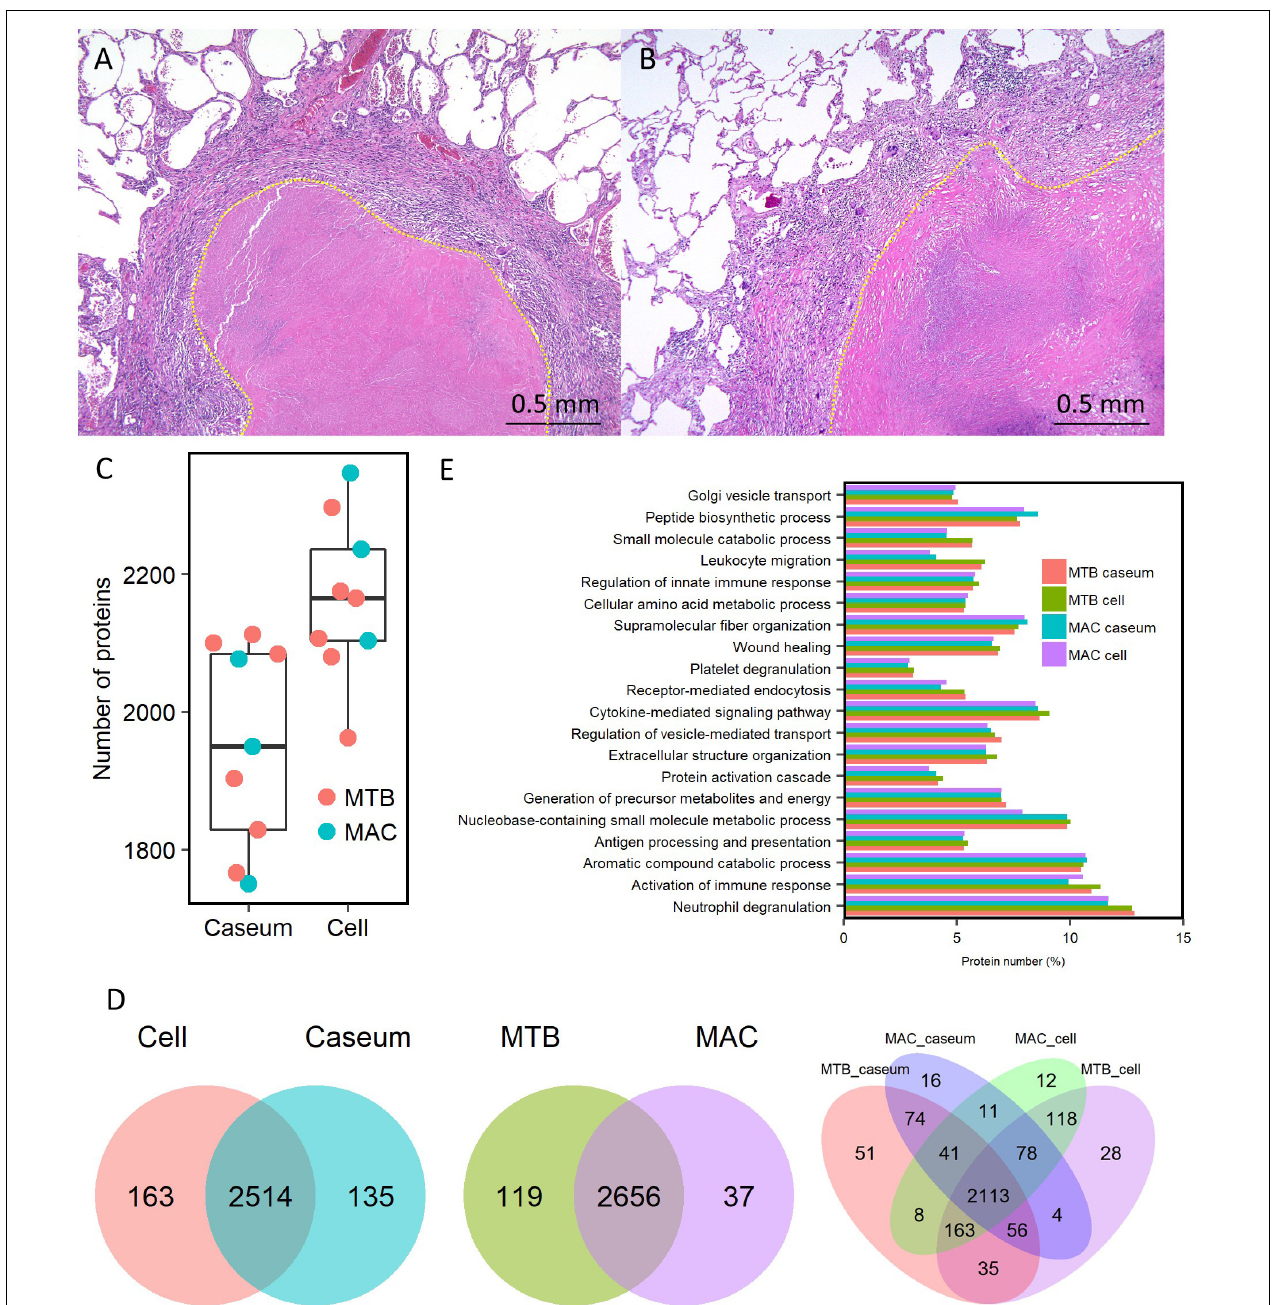
FIGURE 1 | Comprehensive identification of proteins composing mycobacterial granulomatous lesions by a combination of LMD and MS-based proteomics. Representative hematoxylin-eosin (HE)-stained images of granulomatous lesions with necrotic caseum surrounded by fibrotic cells and lymphocytes caused by TB (A) or MAC-LD (B) . Granulomatous sub-compartments were separately collected by LMD followed by processing for MS-based proteomics. The boundary line between the sub-compartment of necrotic caseum and that of fibrotic cells and lymphocytes is shown (yellow dots). (C) Boxplot of the number of identified protein groups with LFQ values from granulomatous sub-compartments of necrotic caseum (Caseum), and fibrotic cells and lymphocytes (Cell) from TB (MTB) and MAC-LD (MAC) granulomas. Bold lines indicate the median of identified protein numbers, a box captures 50% of the measurements, and whiskers span values of the 5–95% interval. The number of proteins identified in each sample is also plotted. (D) Venn diagrams comparing the number of identified proteins in mycobacterial granulomatous lesions. The numbers of proteins detected in at least one sample among sub-compartments are indicated. The protein numbers identified from TB and MAC-LD granulomas (left), caseous and cellular sub-compartments of granulomas (middle) or four mycobacterial granulomatous sub-compartments (right) are indicated. MTB caseum; necrotic caseum from TB granuloma, MTB cell; cellular region from TB granuloma, MAC caseum; necrotic caseum from MAC-LD granuloma, MAC cell; cellular region from MAC-LD granuloma. (E) GO terms related to biological processes of identified proteins in granulomatous sub-compartments. The proportions of annotated protein numbers related to indicated GO terms are presented.